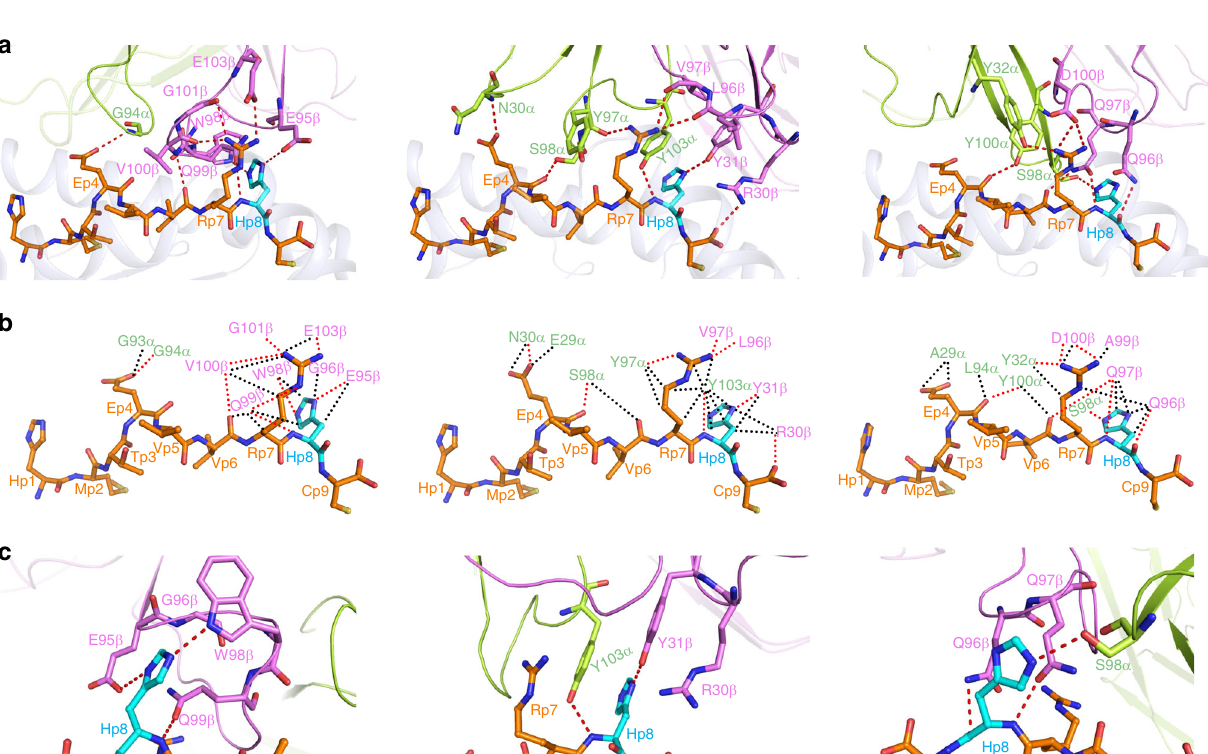
Fig. 6 Interactions of TCRs with the p53R175H peptide. a Interactions between 12-6 (left), 38-10 (center), and 1a2 (right) and the p53R175H peptide. The side chains of contacting residues are shown in stick representation with carbon atoms in green (TCR α chain), violet (TCR β chain), orange (p53R175H), or cyan (mutated P8 His), nitrogen atoms in dark blue, oxygen atoms in red, and sulfur atoms in yellow. Peptide residues are identi fi ed by one-letter amino acid designation followed by position (p) number. Hydrogen bonds are indicated by red dashed lines. b Comparison of interactions between 12-6 (left), 38- 10 (center), and 1a2 (right) and the p53R175H peptide. Hydrogen bonds are red dotted lines and van der Waals contacts are black dotted lines. For